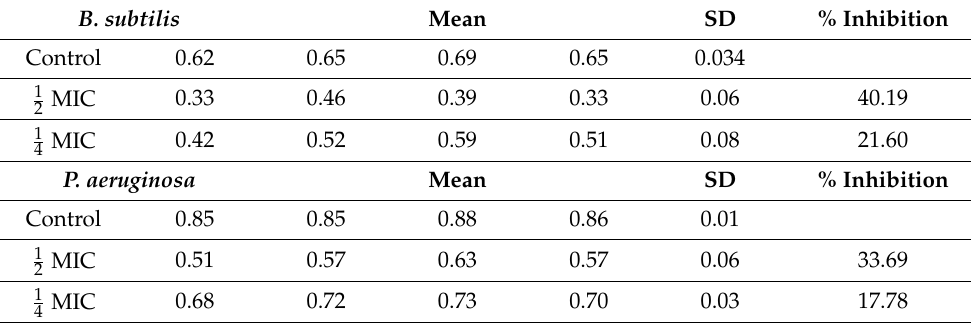
Table 7. Anti-biofilm formation of Fagonia indica against B. subtilis and P. aeruginosa . B. subtilis Mean SD % Inhibition Control